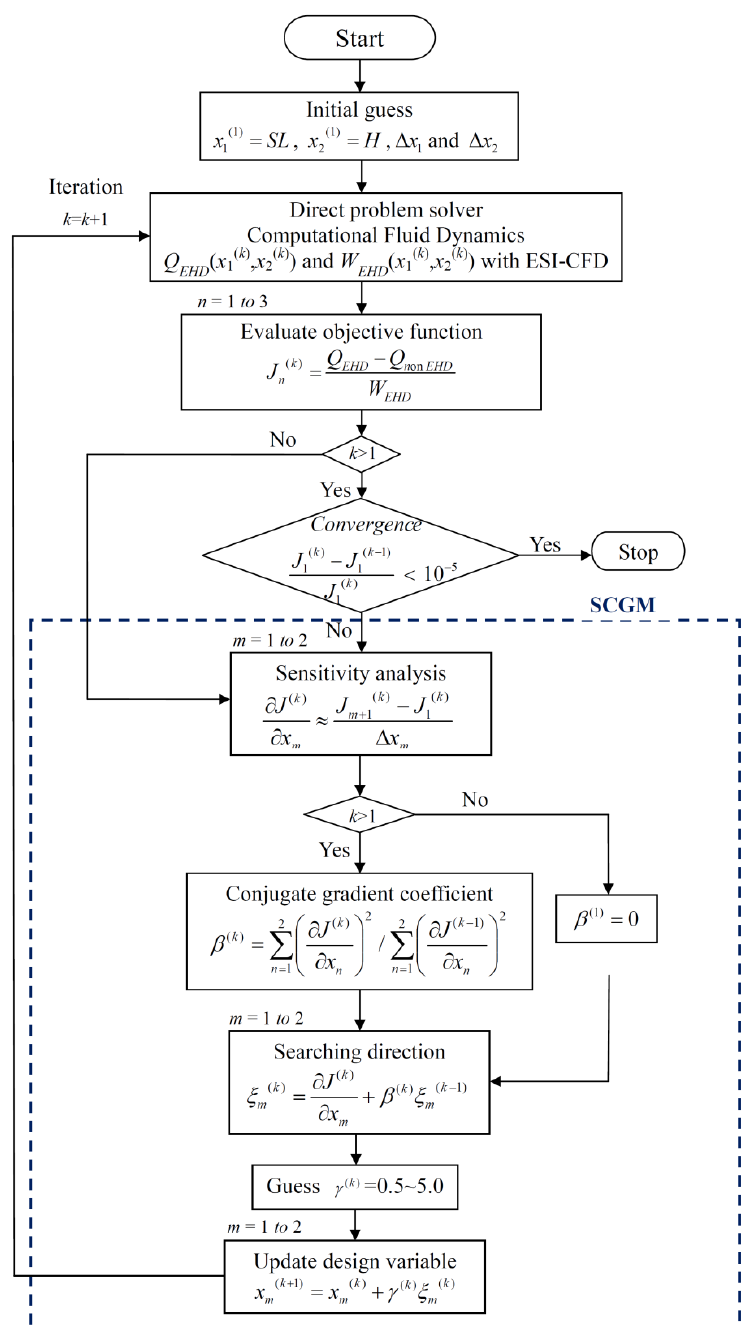
Figure 4. Flowchart for the optimization method.